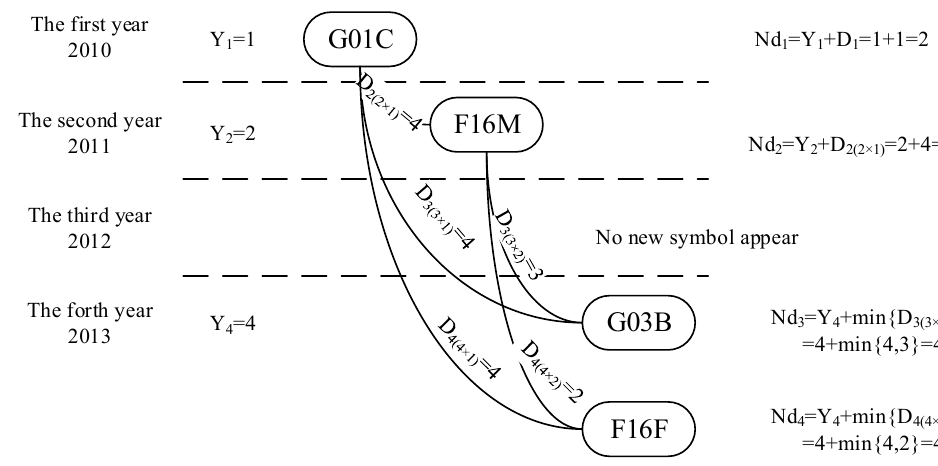
Figure 4. A map of technological changes over time. 1.